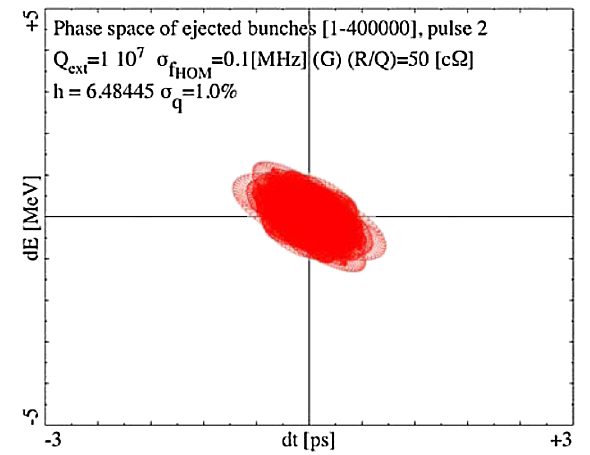
FIG. 11. (Color) Example phase space identical to Fig. 8 (in- cluding same random numbers) but Q ext ¼ 10 7 .